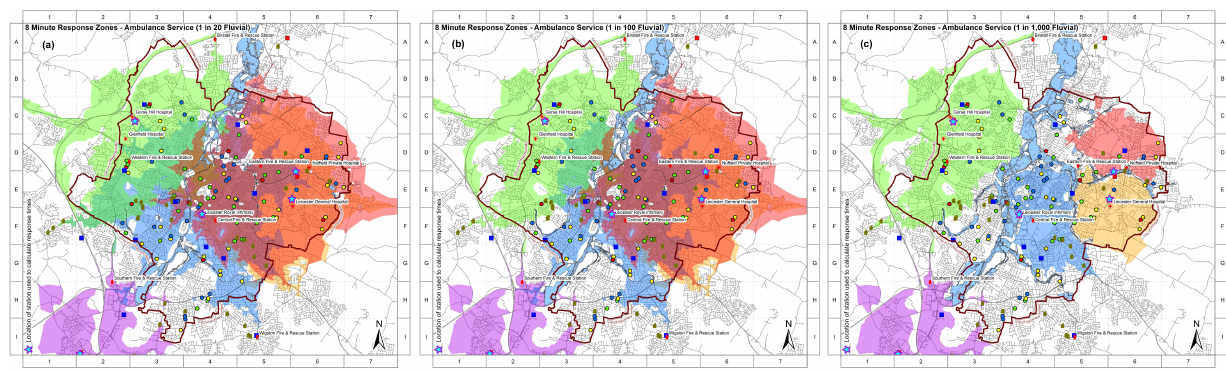
Figure 13. City-scale accessibility (within an 8min time frame) for ambulance service stations under (a) 1 in 20-year, (b) 1 in 100-year and (c) 1 in 1000-year fluvial flooding scenarios. Key access roads referred to in the text are within grid reference E4 in (c)